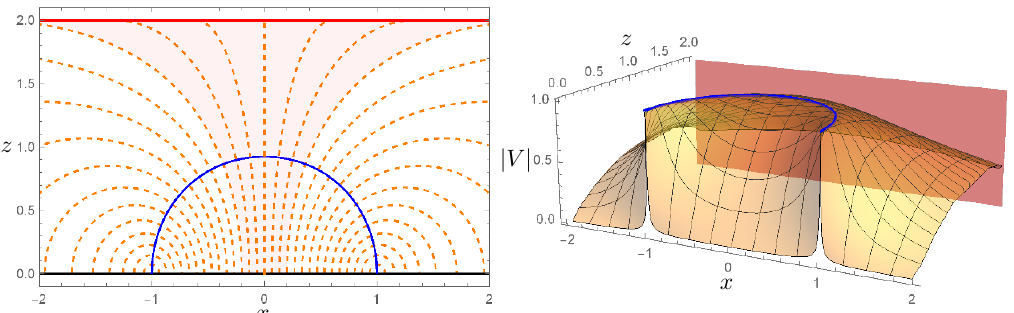
Figure 4 . Typical integral curves and magnitude j V j in a BTZ black hole geometry. The solid lines in blue correspond to the minimal surface, m ( A ), and precisely at this location the magnitude of the vector (cid:12)eld attains its maximal value, j V j = 1. The vector lines in the shaded region correspond to threads that end at the horizon, while the the ones in the white area correspond to threads that go back to the